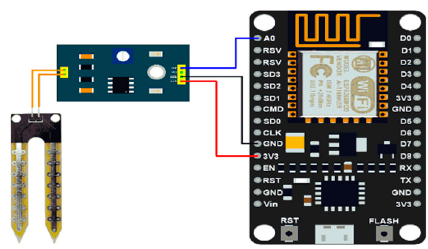
Figure 2. ESP8266-NodeMCU and Sensor FC-28 mounting diagram.